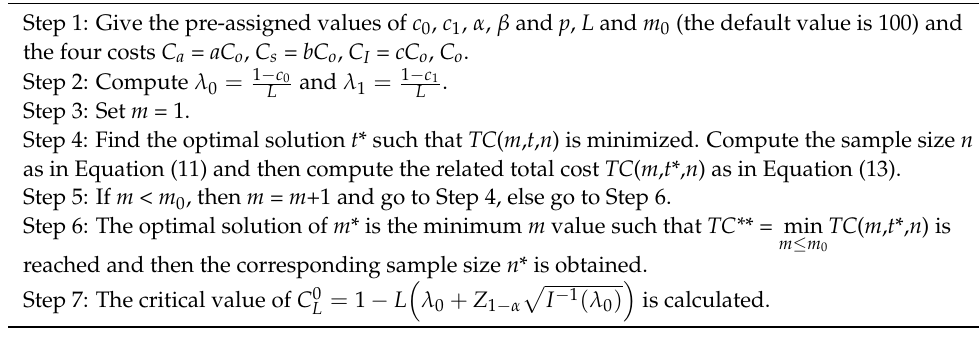
Algorithm 2 Searching for the optimal ( m , t , n